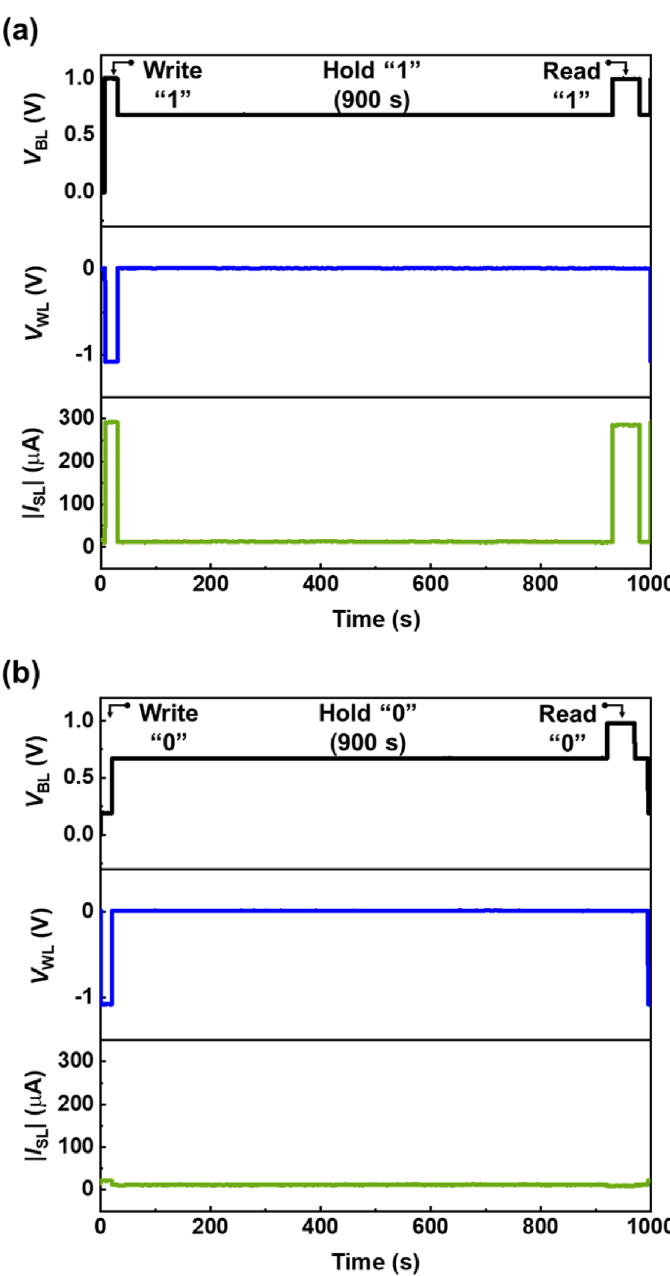
Figure 4. Retention characteristics of ( a ) the “1” state and ( b ) the “0”